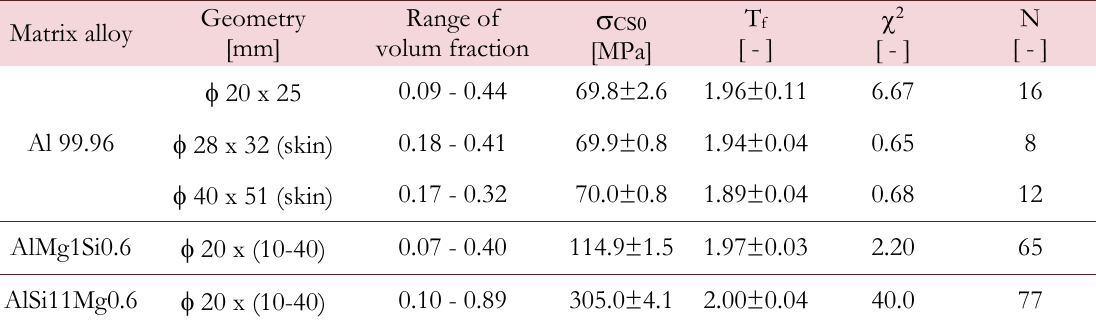
Table 1: Composition, sample geometry and observed scaling exponents for investigated metal foams determined via Eq. (2).  2 is the error of the fitting. N is the number of measured foam samples used for